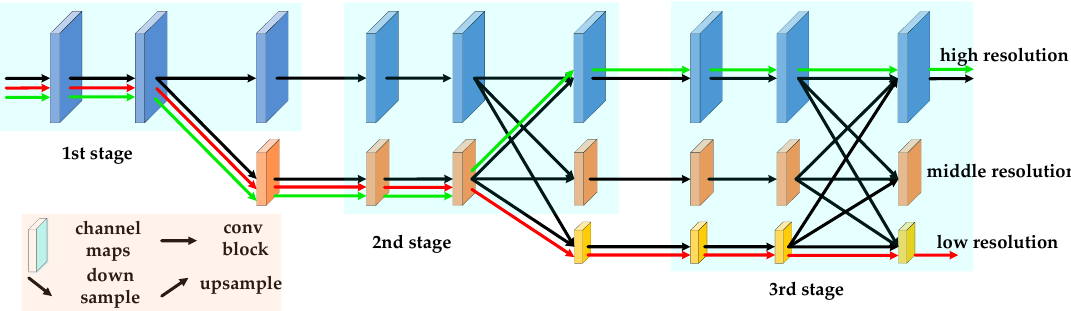
Figure 2. The architecture of representation learning. The red line path indicates the low-resolution representation learning network, and the black line and the green line paths indicate the high-resolution representation recovering network.